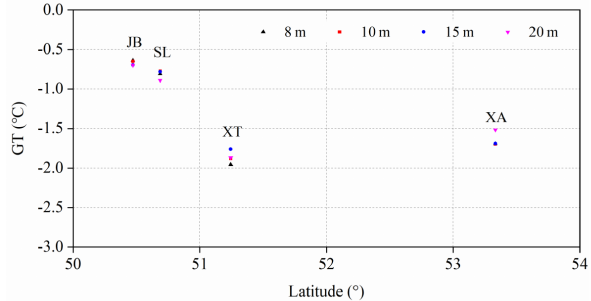
Figure 4. Relationship between latitude and GT along the route of China–Russia crude oil pipelines (CRCOPs).